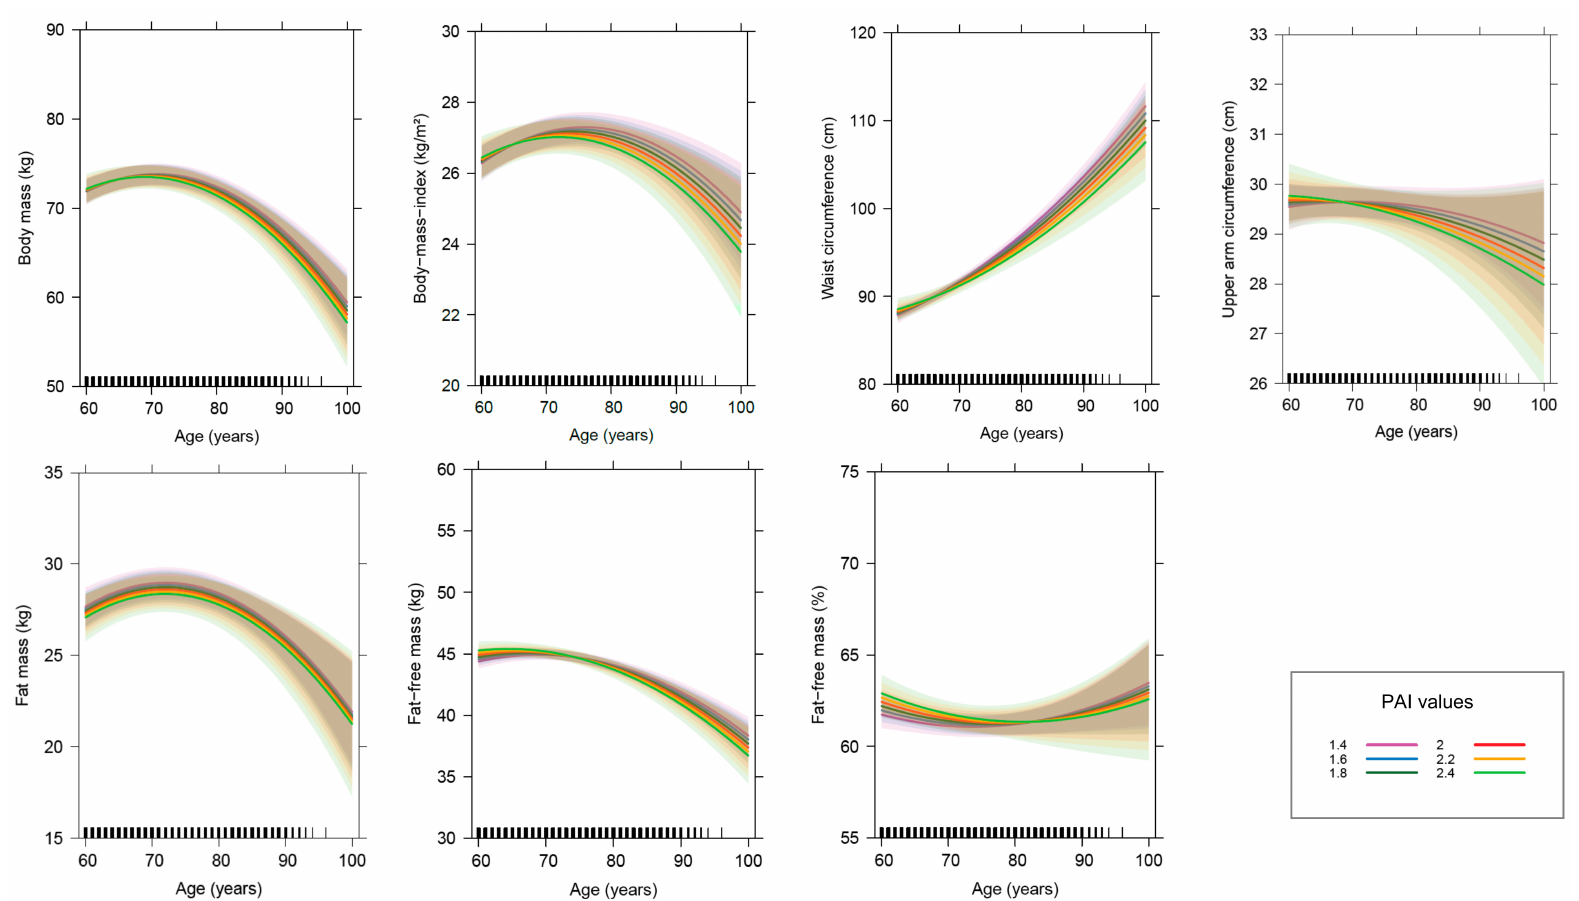
Figure 3. Age-related changes in parameters of anthropometry and body composition in dependence of the physical activity index (PAI). This figure displays the e ff ect of age on parameters of anthropometry and body composition in dependence of the PAI after controlling for other variables in the linear mixed-e ff ects models ( n = 401). The colored lines show the age-related changes in parameters of anthropometry and body composition at di ff erent PAI values, ranging from sedentary / low active to very active lifestyles. The thick lines represent the estimated means and the respective colored areas reflect the 95% confidence intervals. The small black pillars on the x -axis reflect the numbers of records at the respective age of the